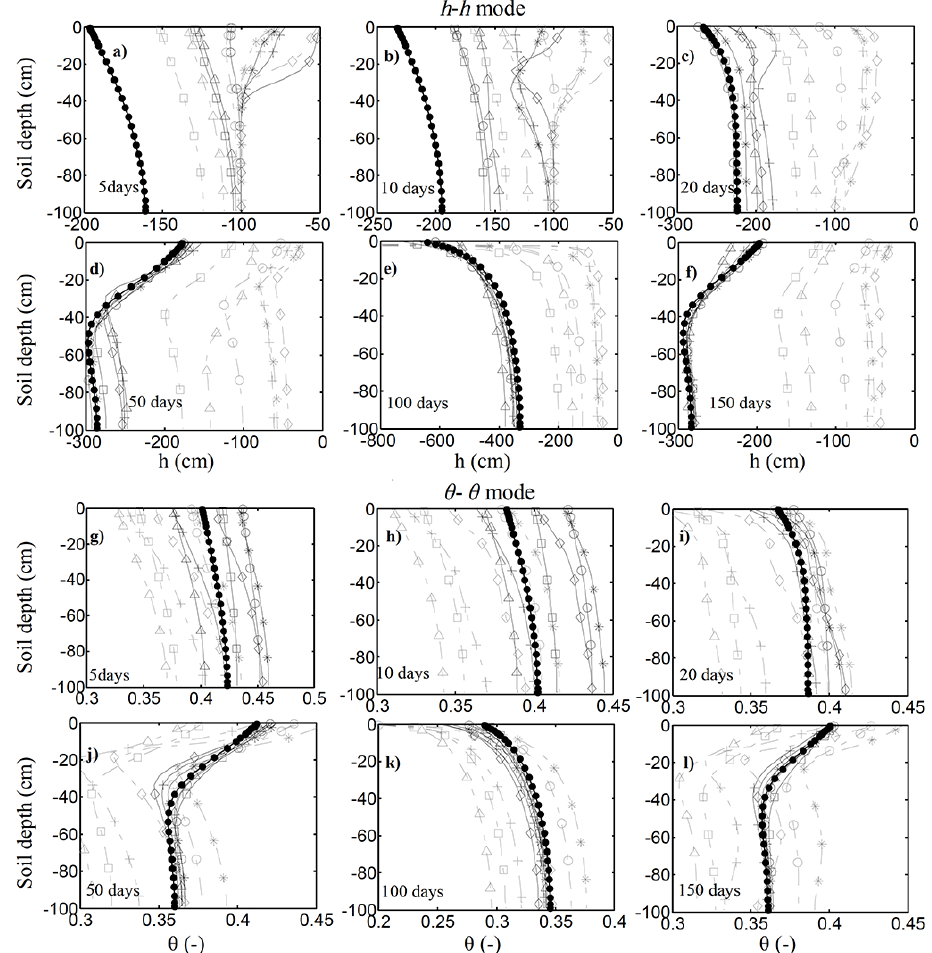
Figure 4. State profiles (solid bold lines, non-filled symbols) retrieved with DSUKF using the h - h (a–f) and θ - θ (g–l) modes, with OD = 2cm and AF = 1/5d − 1 , after the following days: (a, g) 5; (b, h) 10; (c, i) 20; (d, j) 50; (e, k) 100 and (f, l) 150. The corresponding open loop simulations are also depicted (dash-dot gray lines, non-filled symbols). Comparisons account for the six sets of initial guessed parameters: S1( (cid:13) ), S2 ( (cid:3) ) , S3( ∗ ) , S4( 1) , S5( + ) and S6( ♦ ) . The dotted lines with filled circles represent the true